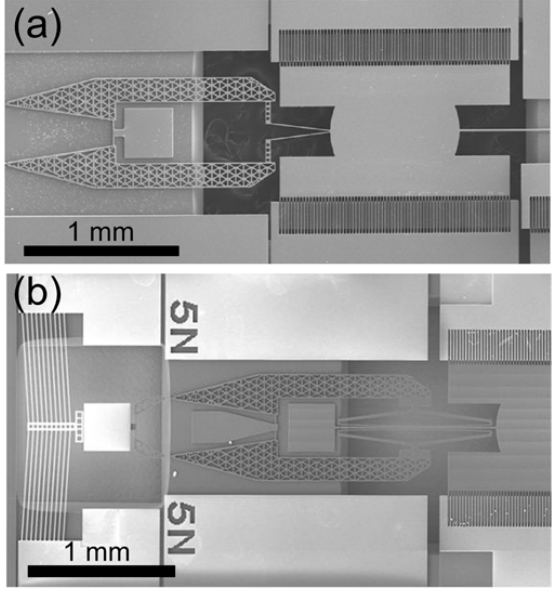
Figure 8. Scanning electron microscope (SEM) images of the fabricated devices: ( a ) Shaft ‐ widening type and ( b ) shaft ‐ holding type. Reproduced with permission from [26].